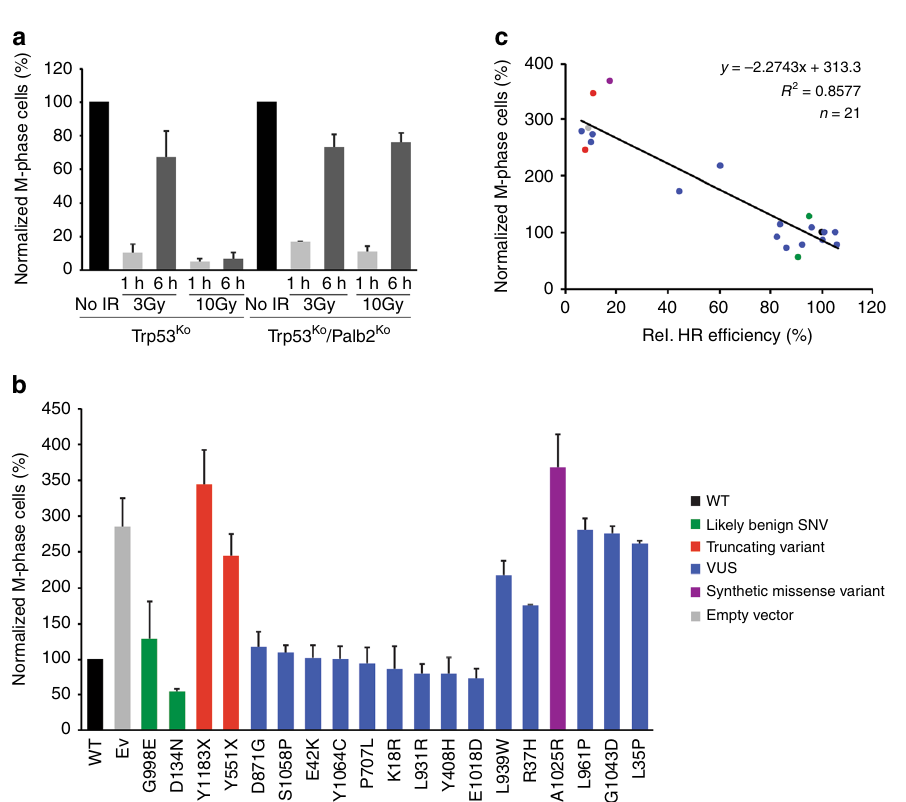
Fig. 6 Effect of PALB2 variants on the DNA damage-induced G2/M checkpoint. a Trp53 KO /Palb2 KO mES cells were irradiated with 3 or 10 Gy of IR and collected at the indicated time points after radiation exposure to assess the mitotic index by phospho-histone H3 (Ser10) staining and FACS analysis. Data represent the mean percentage of mitotic cells (±SEM) relative to the unirradiated cells (no IR), which was set to 100%, from two independent experiments. b Trp53 KO /Palb2 KO mES cells expressing the indicated PALB2 variants were irradiated with 10 Gy of IR and collected 6 h after radiation exposure to assess the mitotic index by phospho-histone H3 (Ser10) staining and FACS analysis. For each variant, the mean percentage of mitotic cells (±SEM) from two independent experiments is shown relative to unirradiated cells, except for p.L939W and p.G998E for which data from three independent experiments is presented. Variants/conditions are categorized by color as in Fig. 2. c Scatter plot showing the correlation between the HR ef fi ciencies and the mitotic index after IR as measured in Fig. 2b and b , respectively. Variants/conditions are categorized by color as in ( b ). The trendline indicates the negative correlation between the HR ef fi ciency and mitotic index after IR, revealing a strong positive correlation between the impact of PALB2 variants on HR and G2/M checkpoint maintenance. Source data are provided as a Source Data fi